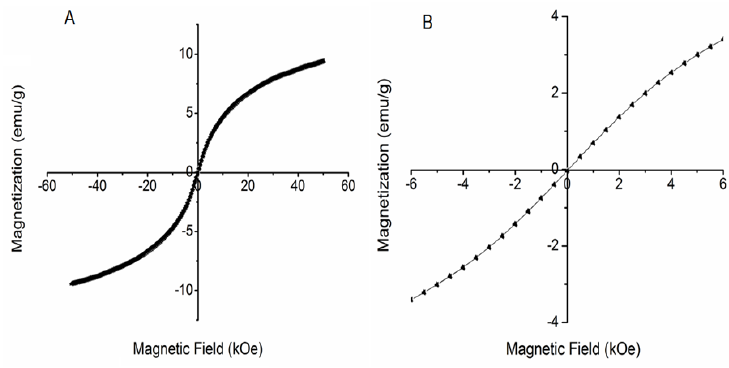
Figure 4. M-H curves of DIO-NPs at room temperature in full scale ( A ) and in extended scale ( B